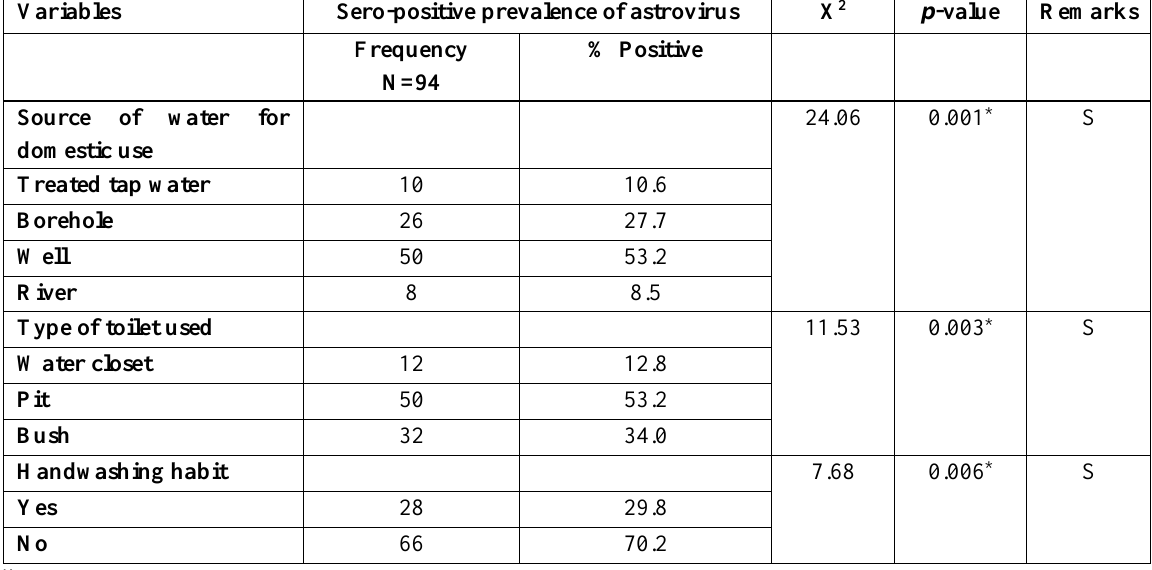
Table 7. Risk factors associated with sero-positive prevalence of astrovirus among children.